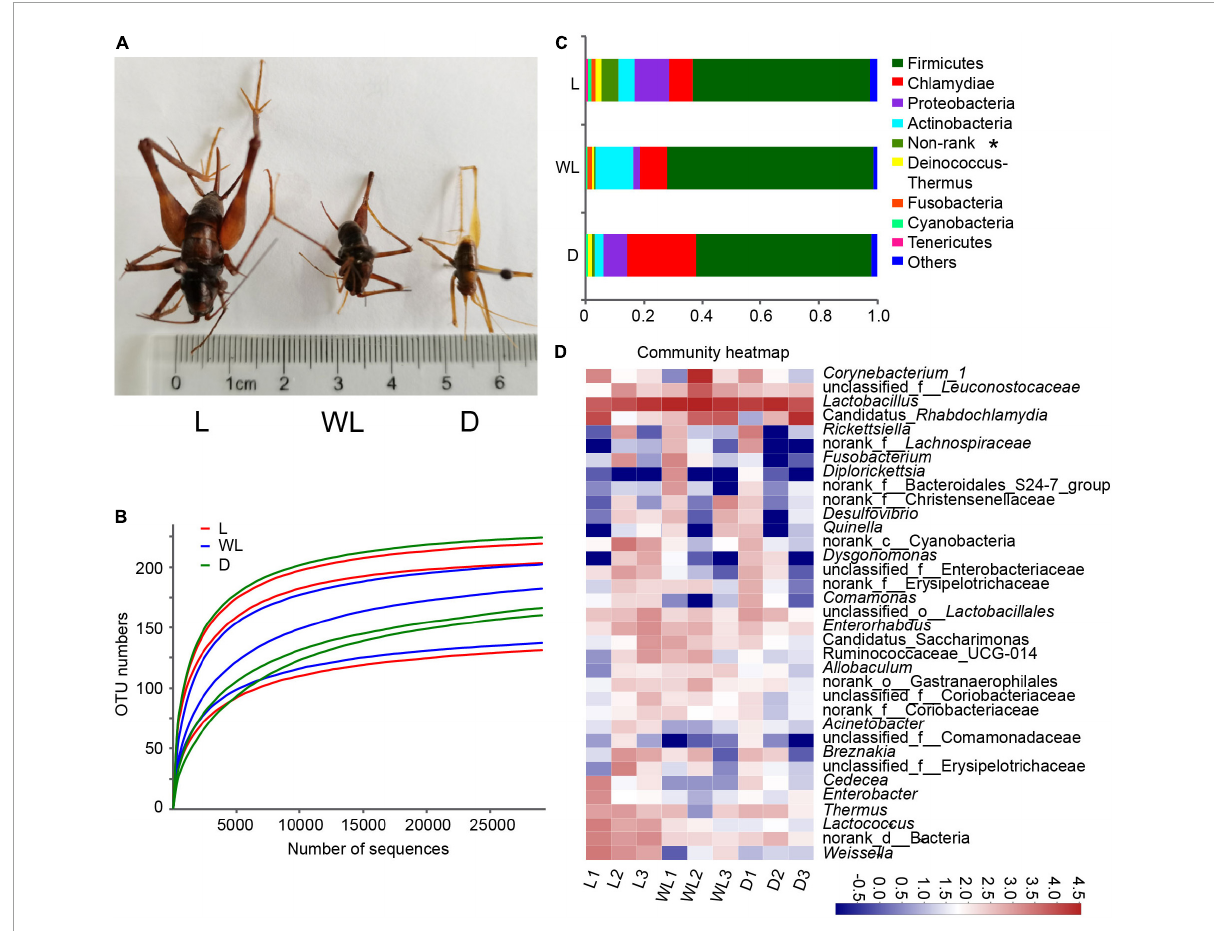
FIGURE1 Gut bacteria dynamics among different light-strength regions in Diestrammena japanica . (A) Morphology of D. japanica from different light-strength regions. (B) Rarefaction curves generated from randomly subsampled data sets with the same number of 16S rRNA gene deep sequencing. (C) Relative abundance of gut bacteria at the phylum level. (D) Relative abundance of the top 35 abundance genera gut bacteria, the color scales display the bacterial relative abundance (log10 transformed). L, light region; WL, weak light region; D, dark region. These labels are the same as in the other